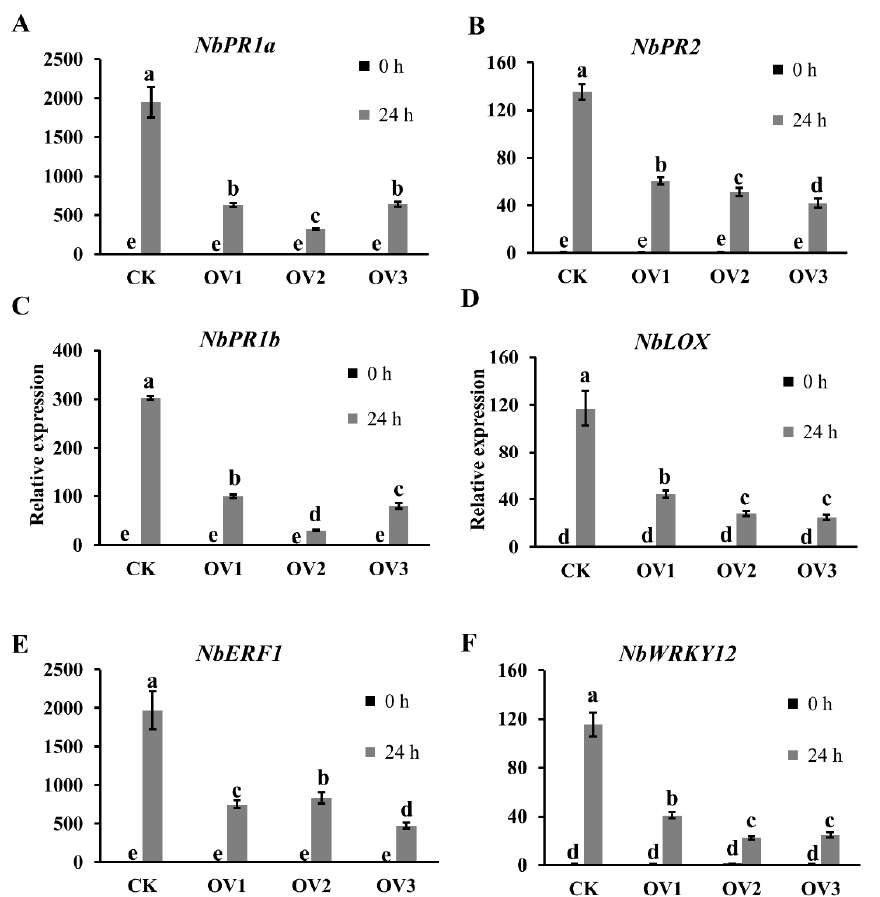
Figure 6. Downregulation of defense-related genes mediated by LtCSEP1 in LtCSEP1 transgenic overexpressing N. benthamiana lines. Transcript level of the NbPR1b ( A ), NbPR2 ( B ), NbPR1b ( C ), NbLOX ( D ), NbERF1 ( E ), and NbWRKY12 ( F ) genes in LtCSEP1 transgenic lines during L. theobromae infection. Bars indicate means of three independent replicates and different letters indicate significant differences ( p < 0.05).